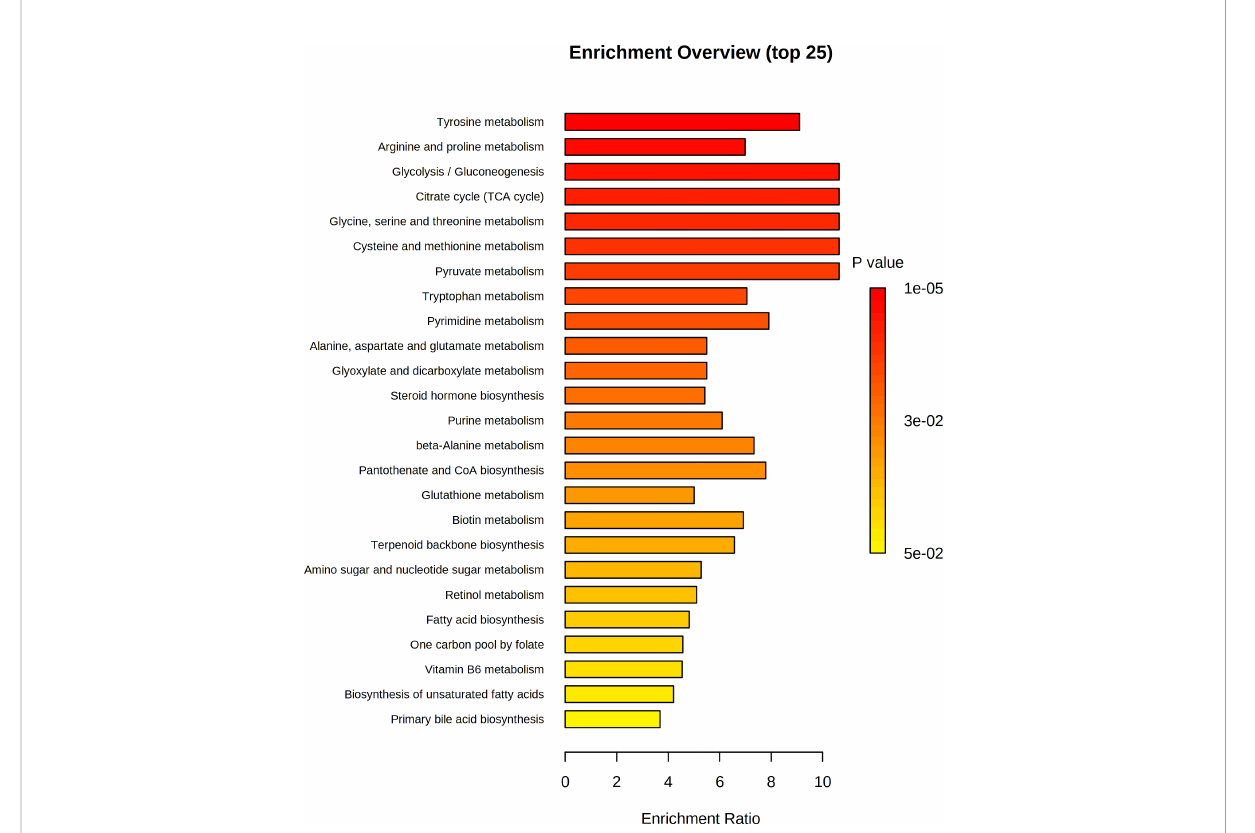
FIGURE 12 Pathway enrichment analysis of differential metabolites in both positive and negative ionization mode. The Rich Factor in the x-axis indicates the ratio of the number of differential metabolites annotated to the pathway to all the metabolites annotated to the pathway.